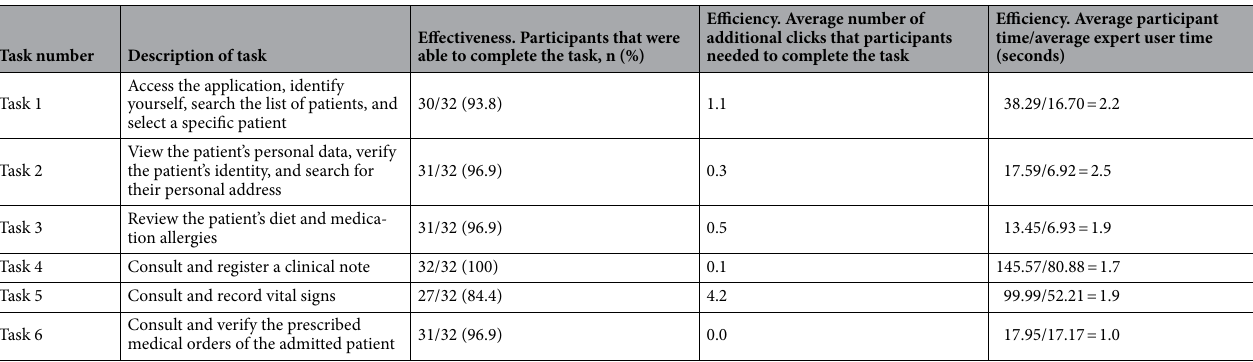
Table 3. Effectiveness of participants, efficiency of the application and efficiency comparing participant and expert